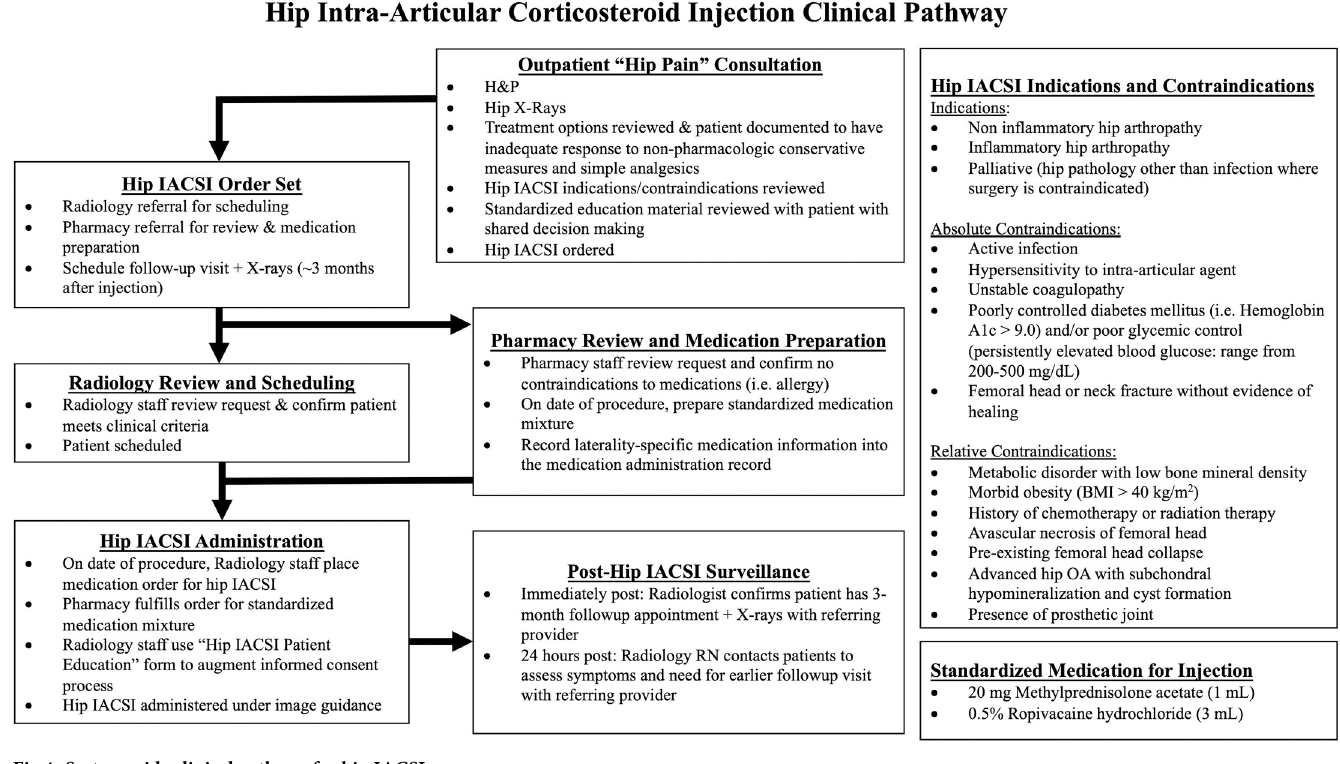
Fig 4. System-wide clinical pathway for hip